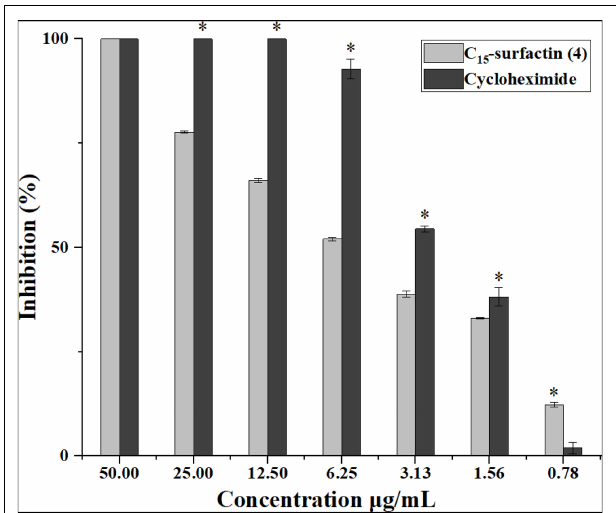
FIGURE 6 | Effect of compound ( 4 ) (C 15 -surfactin) and referenced cycloheximide on conidia germination of FOC. Asterisks indicate a significant difference between the control (cycloheximide) and compound ( 4 ) treated conidia ( t -test; ∗ P < 0.05). Error bars represent the standard deviation from three